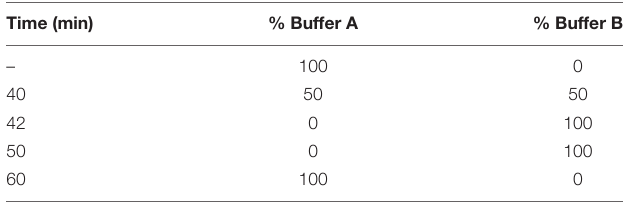
TABLE 1 | HPLC chromatographic conditions used to quantify peptide 11-mer. Time (min) % Buffer A